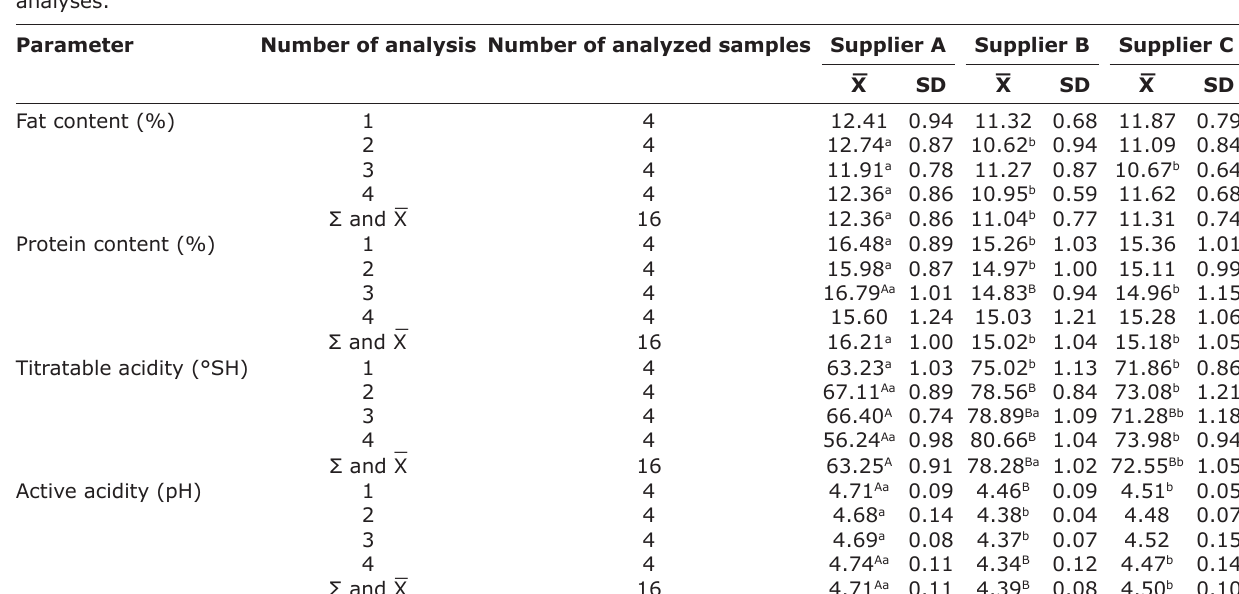
Means in rows marked with different letters differ significantly: capital letters - for p≤0.01; lowercase letters - for